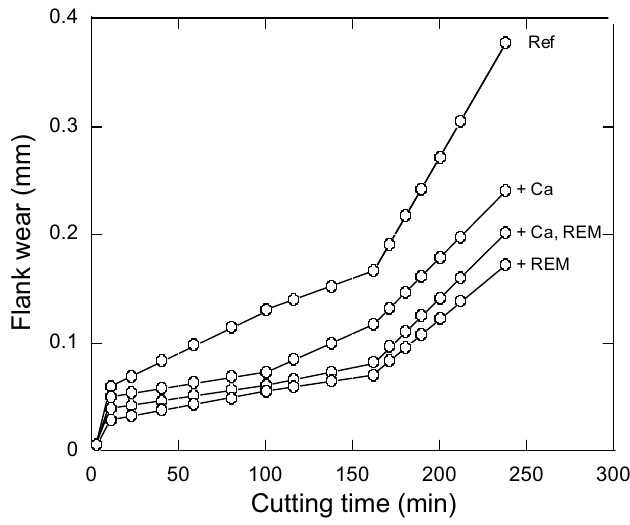
Figure 20. The effect of Ca and REM addition on the flank wear of free-cutting steels